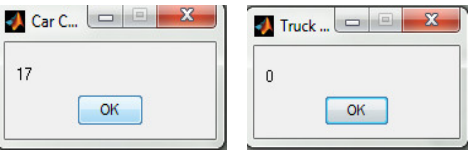
Figure 26: Car & Truck Counts of Fig.1 (0.15m)